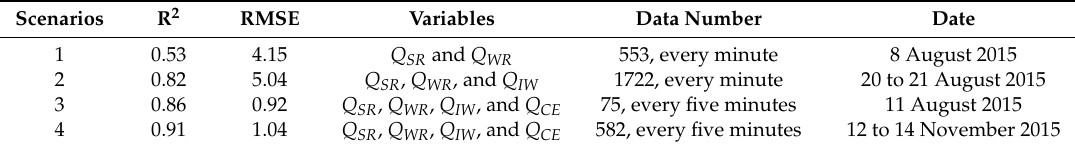
Table A1. Comparison of simulated and measured values under di ff erent scenarios.